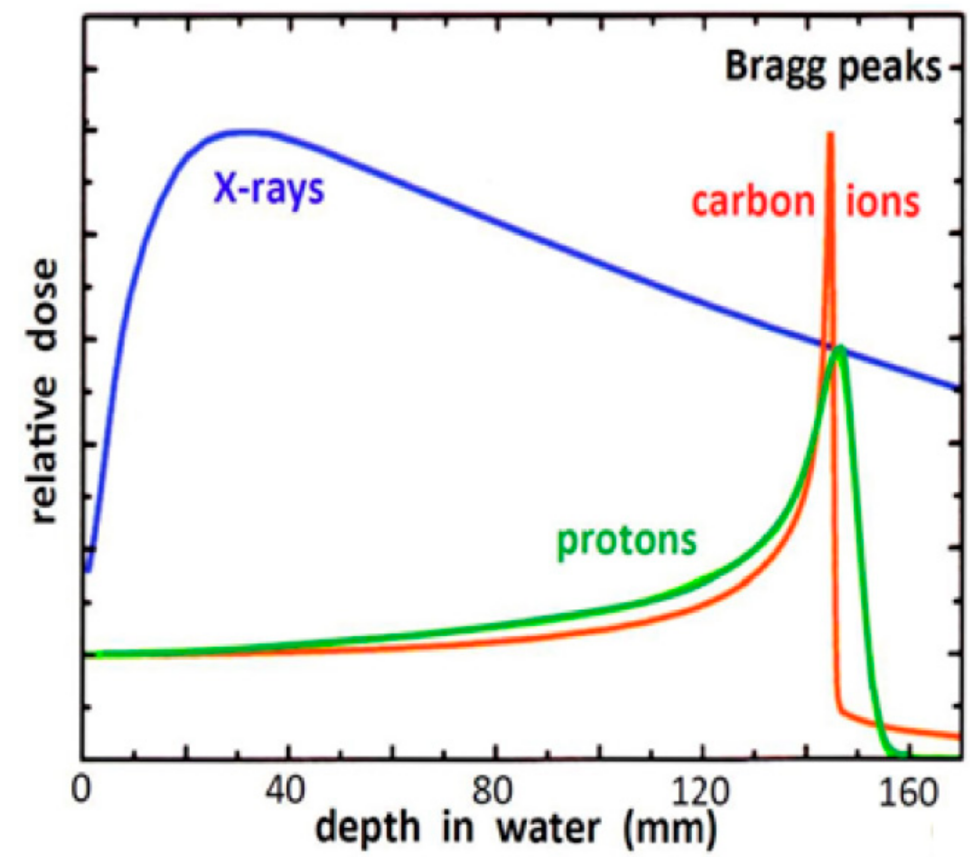
Figure 1. Energy deposition in water by X-ray photons, protons and carbon ions. The energy of the X-rays is 21 MeV. The energy of the two particles is selected to provide the same range: 148 MeV/u for protons and 270 MeV/u for carbon ions